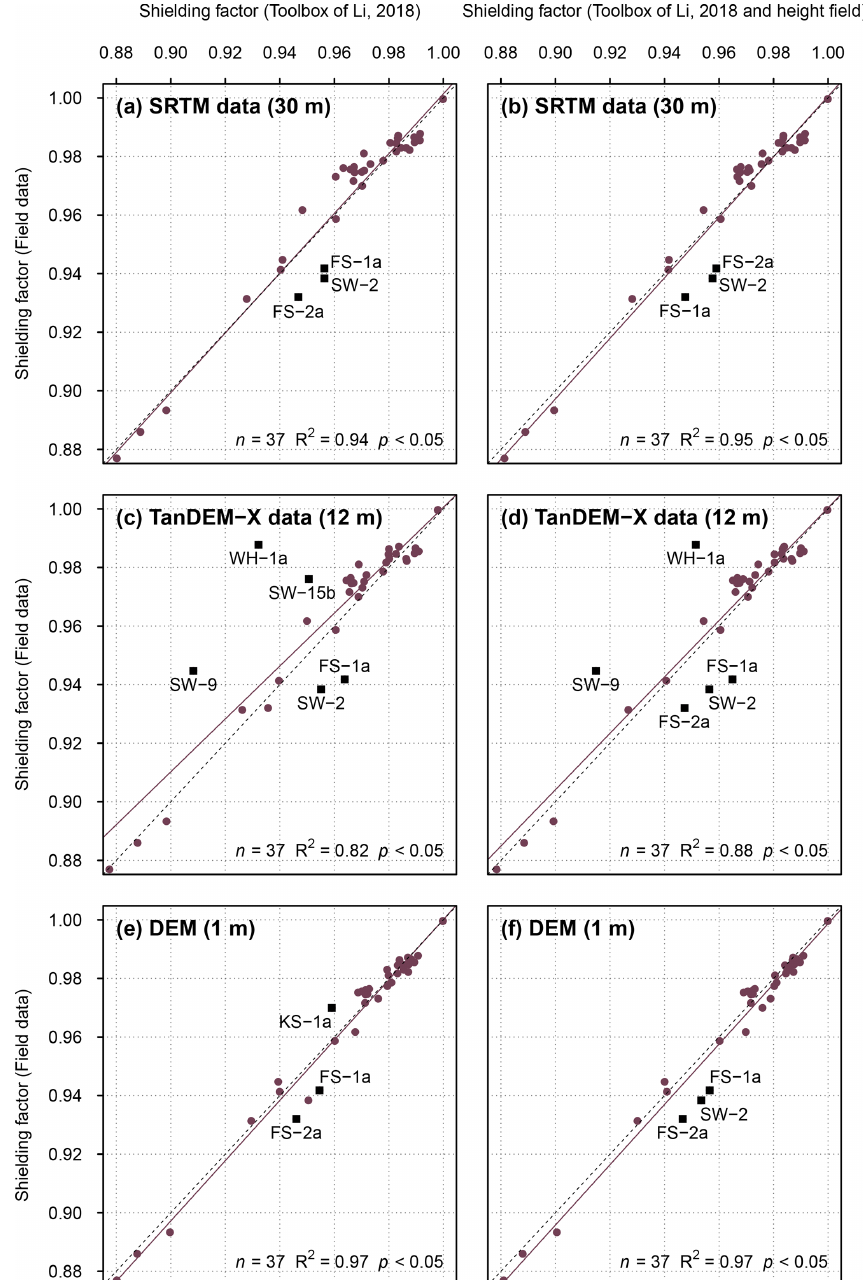
Figure 3. (a) Topographic shielding factors for boulders in the southern Black Forest determined with the ArcGIS toolbox of Li (2018) and SRTM elevation data (NASA Jet Propulsion Laboratory, 2013) versus those derived from field data. Panel (b) is the same as (a) , but with a correction for the boulder height. (c) Topographic shielding factors calculated with the ArcGIS toolbox and a TanDEM-X-DEM versus those derived from field measurements. Panel (d) is the same as (c) , but the shielding factors were corrected for the boulder height. (e) Topographic shielding factors calculated with the ArcGIS toolbox and the 1m DEM versus those derived from field measurements. Panel (f) is the same as (e) , but with a correction for the boulder height. Outliers are marked with dark red squares. Linear models and 1:1 lines are marked with solid and dashed lines, respectively. The numbers in parentheses refer to the spatial resolution of the elevation